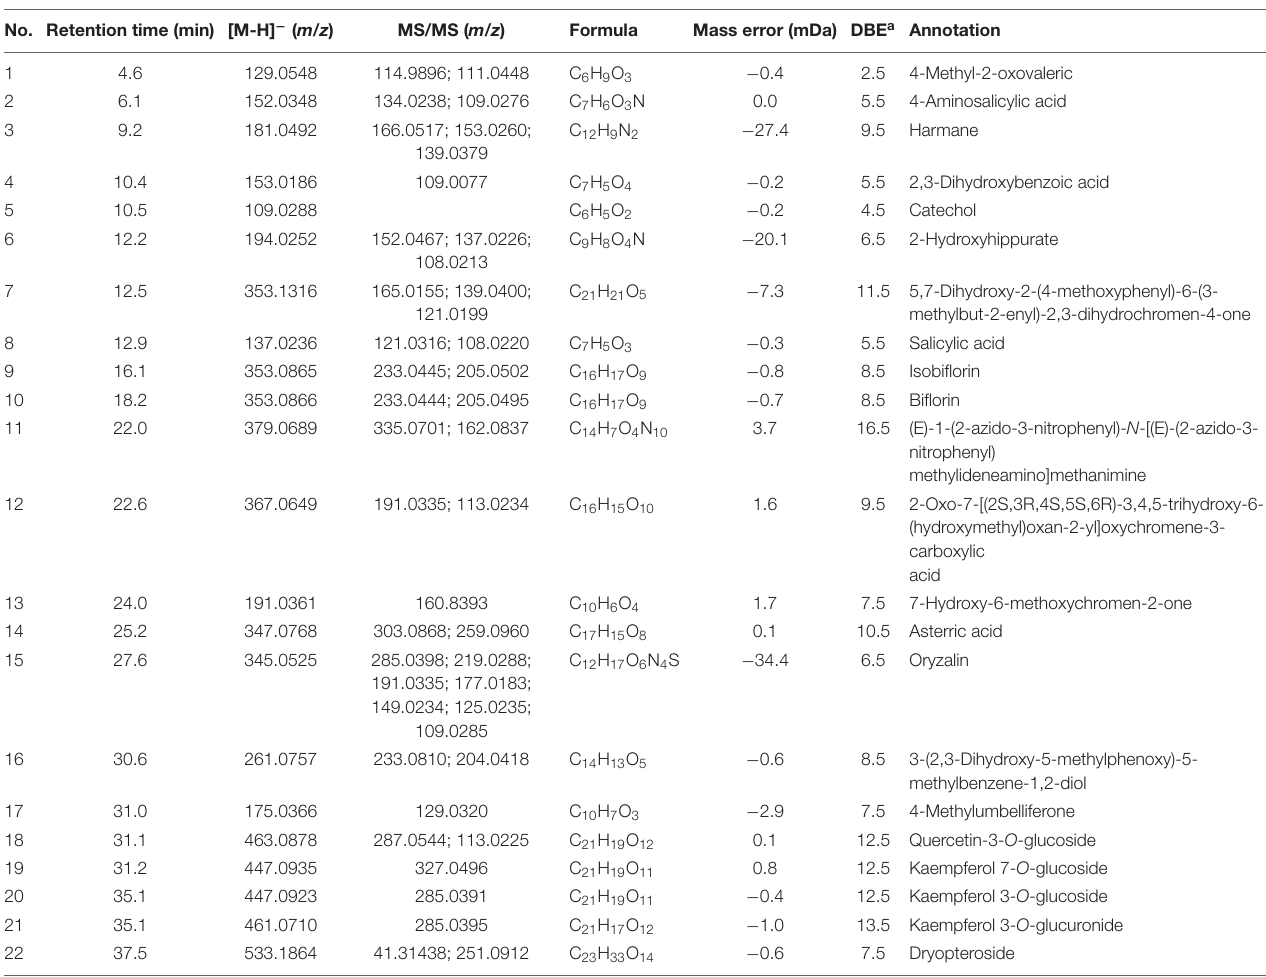
TABLE 1 | Tyrosinase inhibitors in the Dryopteris crassirhizoma rhizome (DCR) extract identified using liquid chromatography–tandem mass (LC–MS/MS) in the negative ion mode. No. Retention time (min) [M-H] − ( m/z